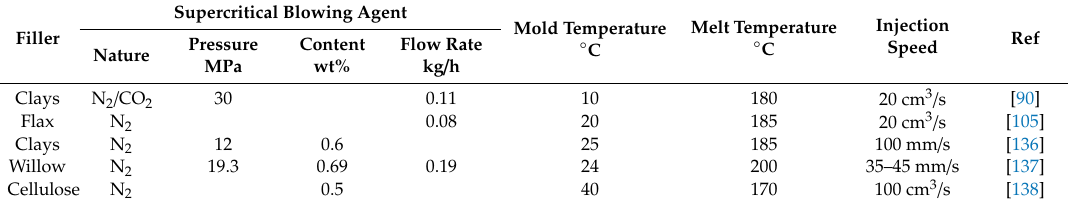
Table 2. PLA composites by foam injection molding (FIM) technique and their operating conditions.